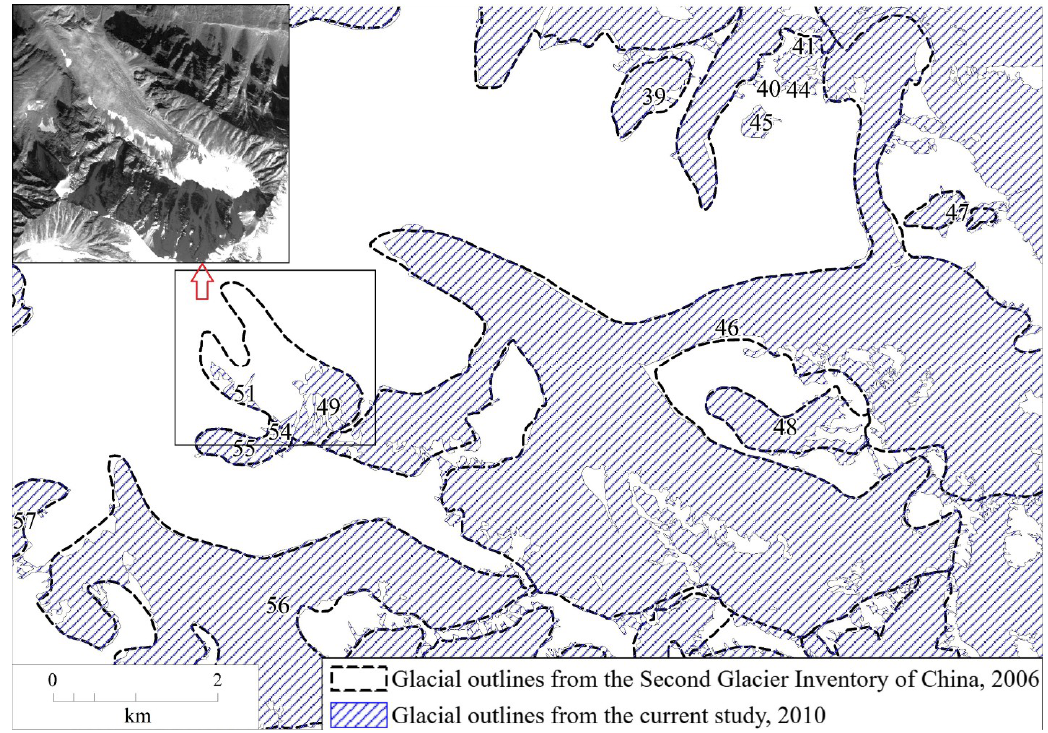
Figure 18. Comparison of the contours of glaciers in the basin of the Sangadyr river, obtained by us, with the contours from the “Second Glacier Inventory of China”. Upper left corner—a fragment of SPOT 5 satellite image (2010).